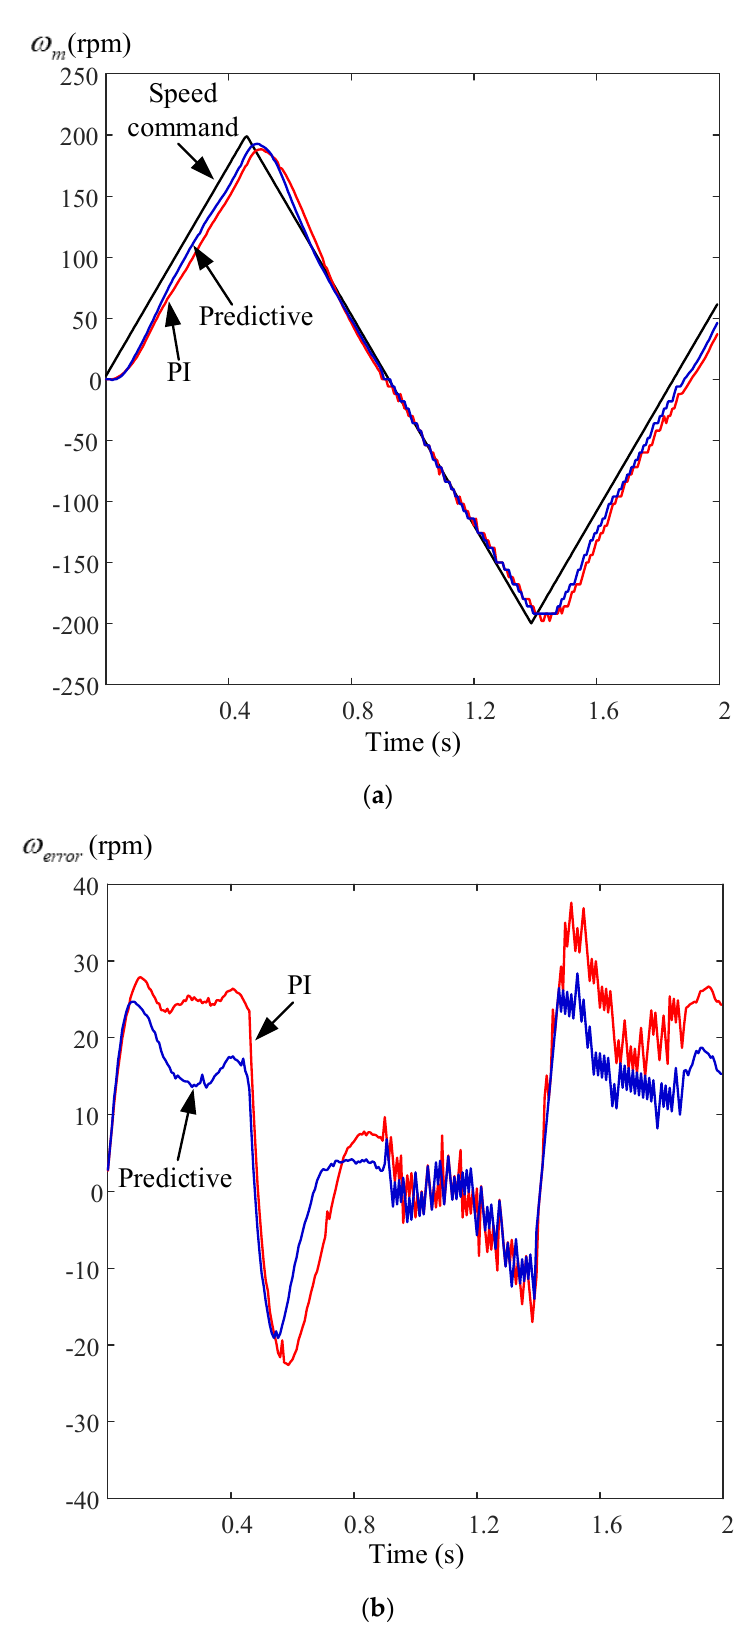
Figure 13. Measured triangular responses using di ff erent controllers at 200 r/min. ( a ) speeds, ( b ) errors.